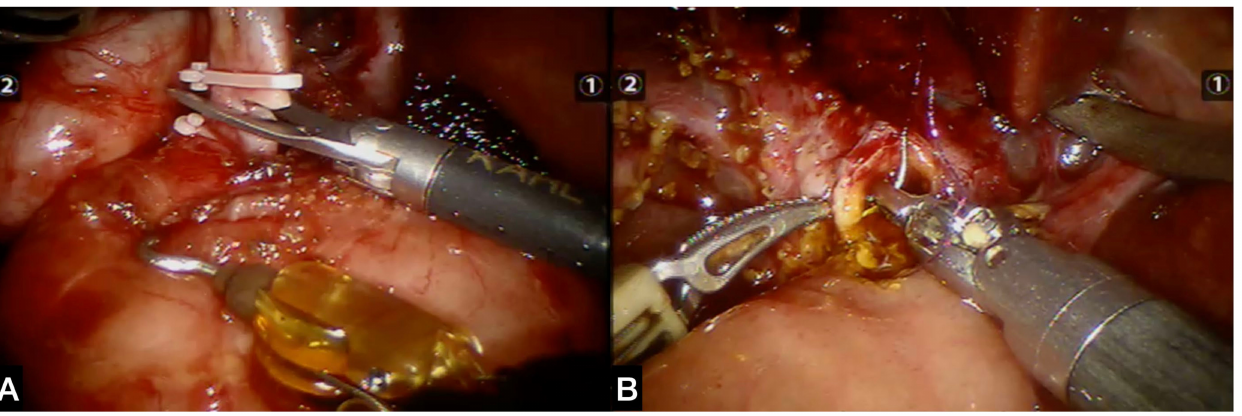
Figure 3. ( A ) Robotic exeresis of choledochal cyst and ( B ) subsequent